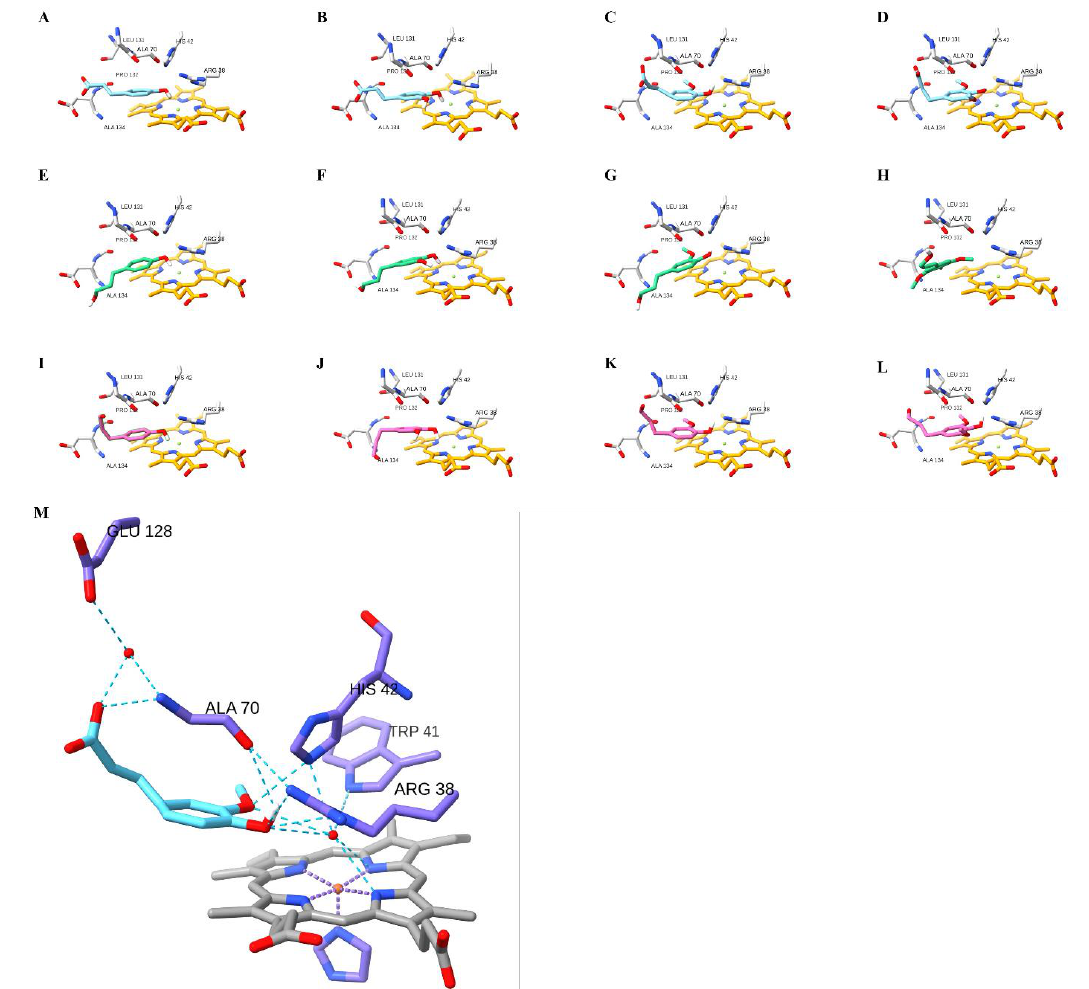
Figure 7. Molecular docking of phenylpropanoids in PviAPX. The acids ( A ) p -coumarate, ( B ) caffeate, ( C ) ferulate, and ( D ) sinapate are shown in light blue; ( E ) p -coumaryl alcohol, ( F ) caffeyl alcohol, ( G ) coniferyl alcohol, and ( H ) sinapyl alcohol are shown in green; aldehydes: ( I ) p -coumaryl aldehyde, ( J ) caffeyl aldehyde, ( K ) coniferyl aldehyde, and ( L ) sinapyl aldehyde are shown in pink. ( M ) shows the hydrogen bond network of the docked ferulate (light blue). Red color indicates oxygen and blue indicates nitrogen. This figure was produced using the Chimera package version 1.3 (UCSF, NIH P41